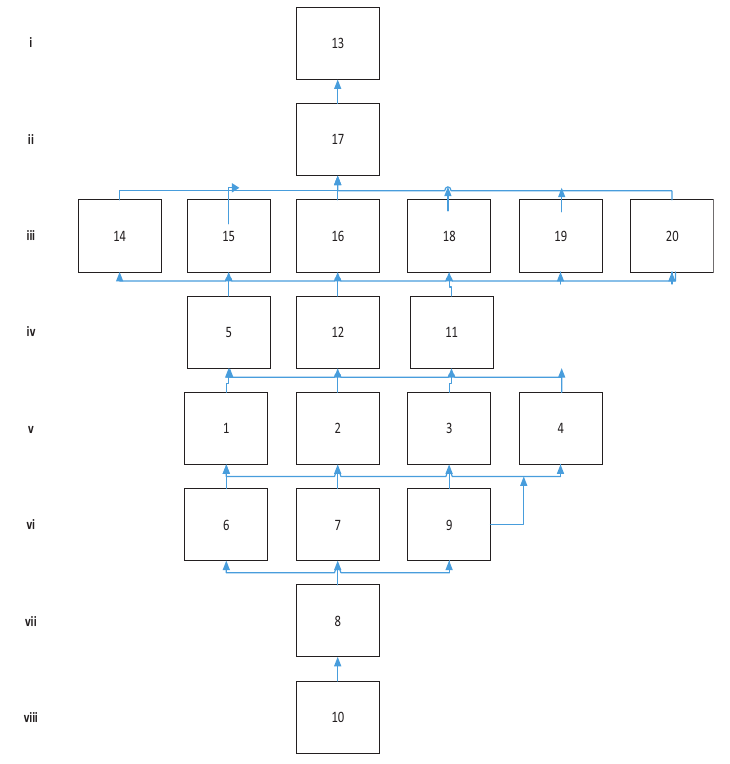
Figure 2. ISM-based model of lean, green practices and sustainable performance